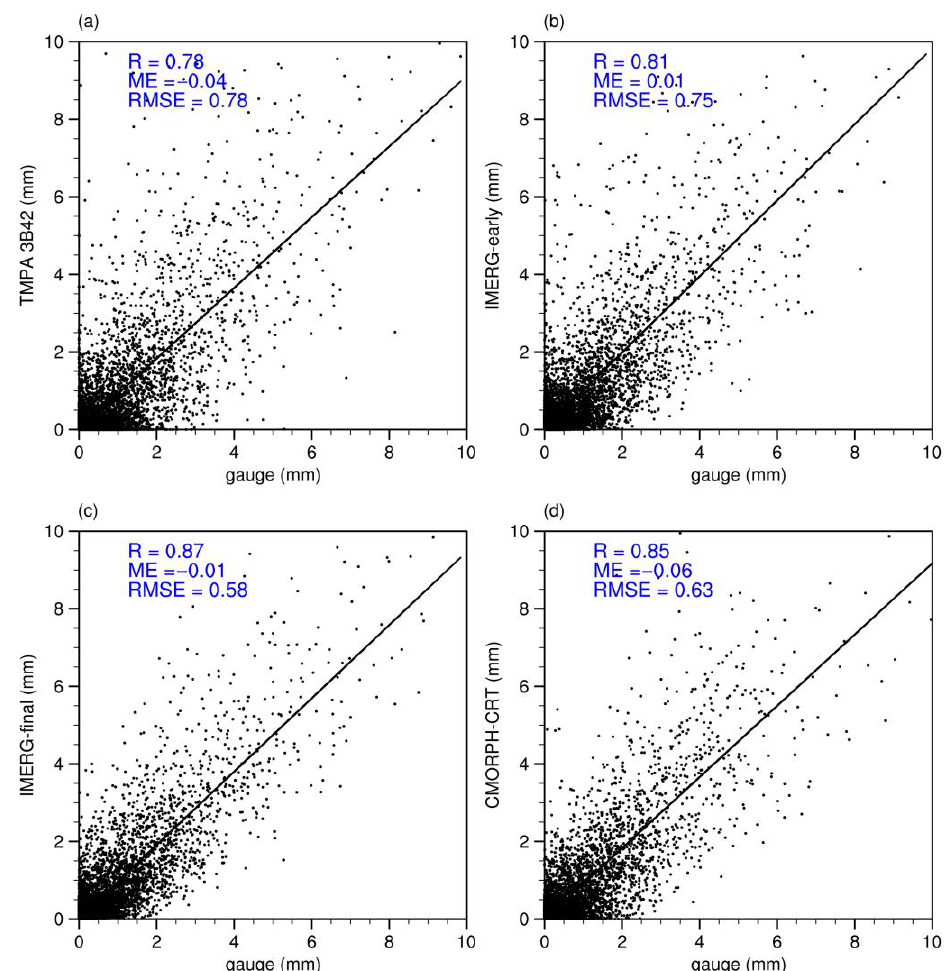
Figure 2. Scatterplots of satellite- vs. gauge-based precipitation in Hunan at 3-hourly. ( a ) TMPA 3B42; ( b ) IMERG-early; ( c ) IMERG-final; and ( d ) CMORPH-CRT.